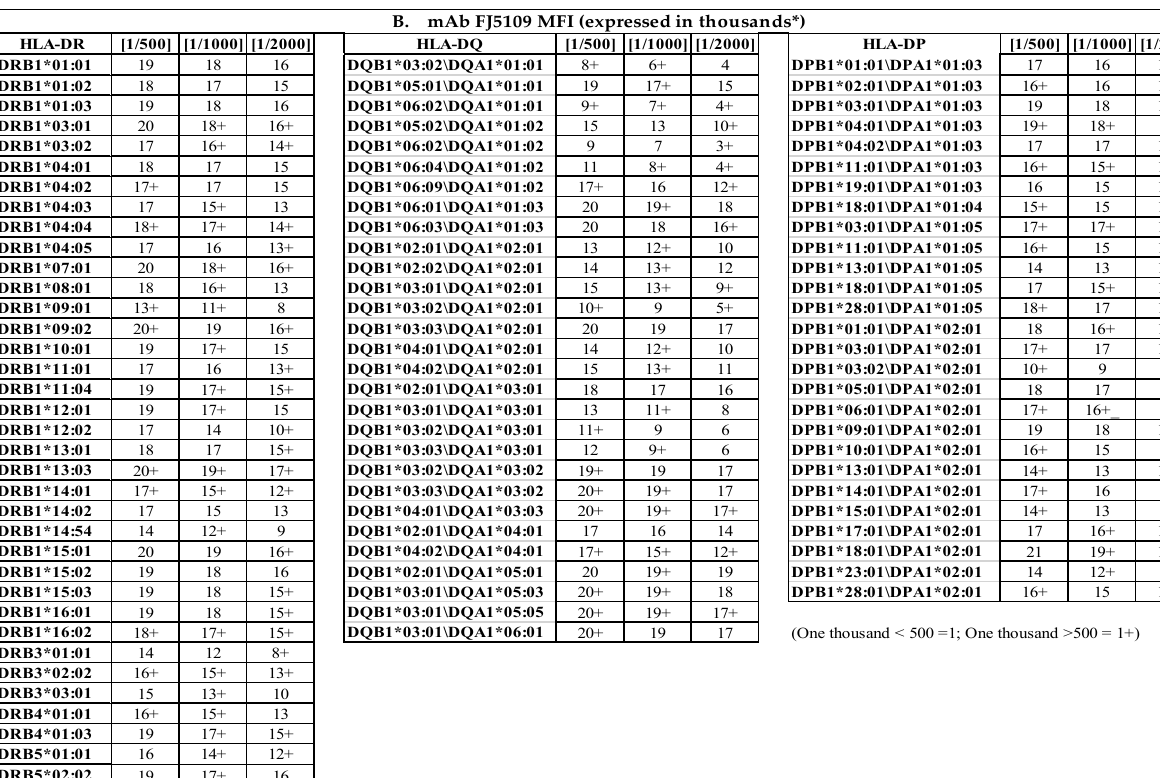
Figure 5. ( A ) The HLA-I polyreactive mAb TFL-006, which recognizes shared epitopes found on β 2m-free heavy chains of HLA-I alleles (open conformers, OC), binds to most of the HLA-I molecules coated on LABScreen (LS), but not those on LIFECODES (LC) SABs. The binding affinity of antibodies is measured as normalized MFI. Note LC-SABs are totally negative (MFI <500). ( B ) The HLA-II polyreactive mAb FJ5109 binds to most of the HLA-II molecules coated on LABScreen (LS). The binding affinity of antibodies is measured as normalized MFI on the SABs with the mAb. Since the mAb binds to all of the three loci of HLA-II molecules, presence of a shared epitopes among all HLA-II molecules is indicated.